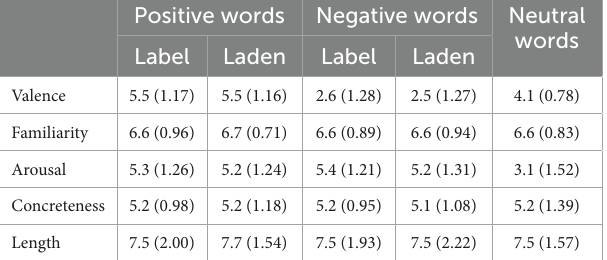
TABLE 2 Means ( M ) and standard deviation (SD) for English emotion- label, emotion-laden, and neutral